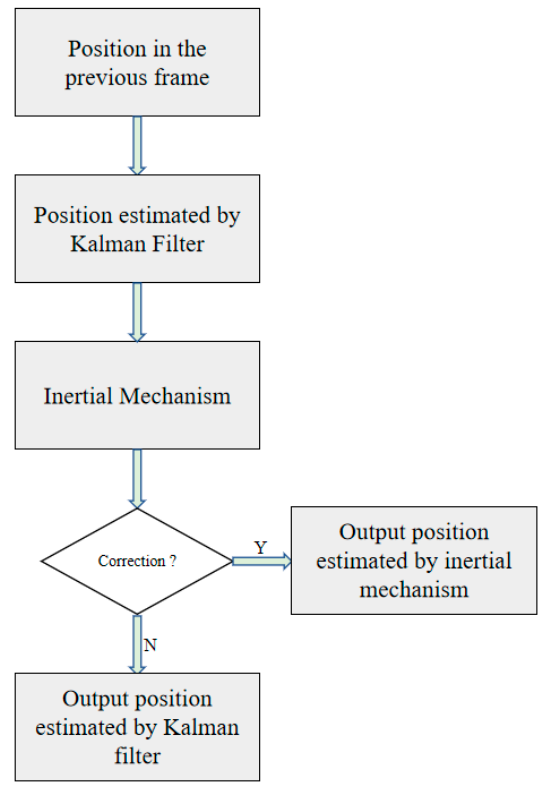
Figure 3. Flowchart of motion estimation algorithm.